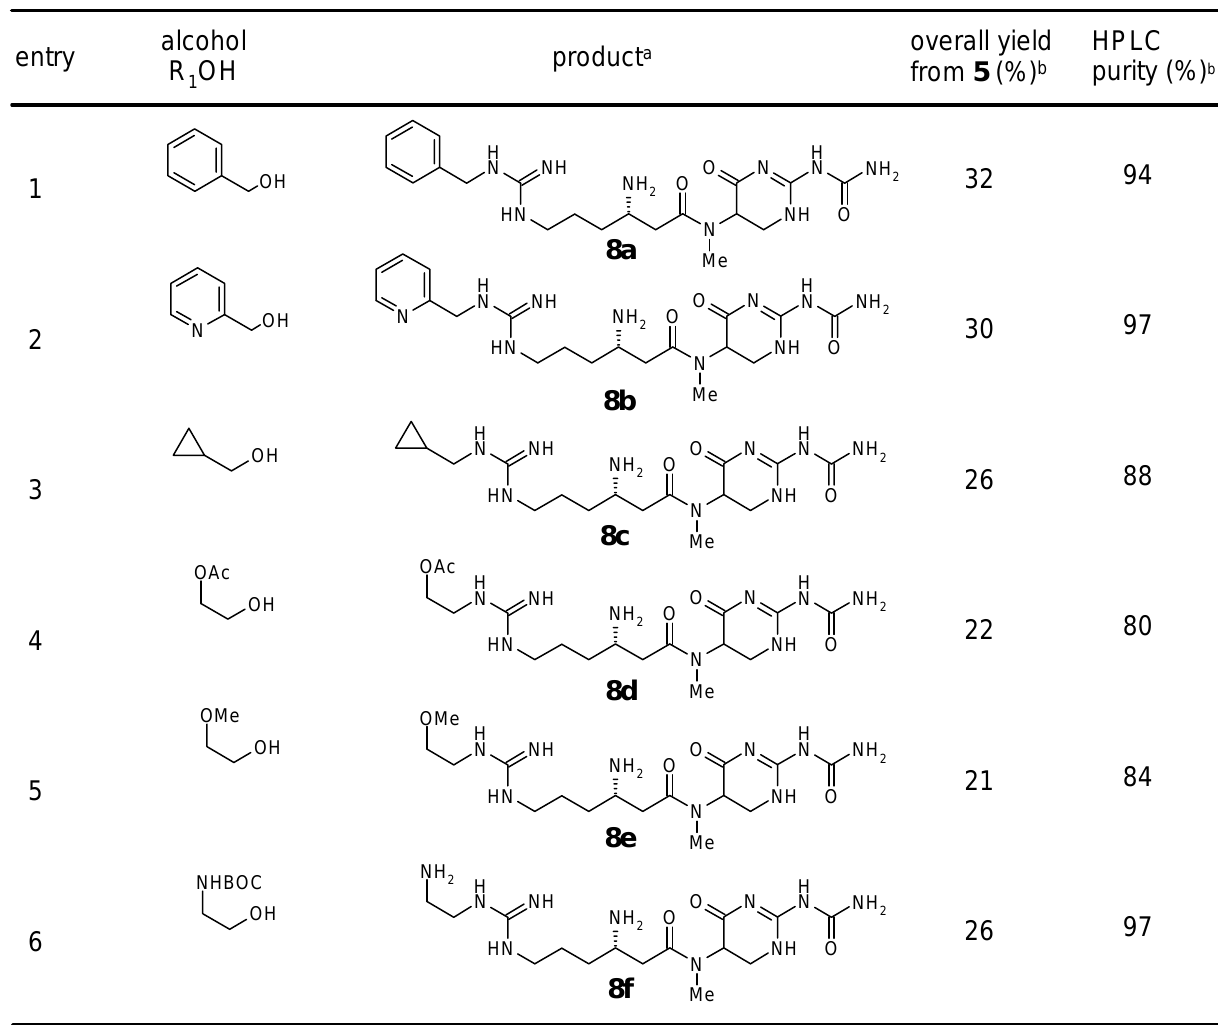
Table 1: A nalogs of TAN 1057 A,B by parallel